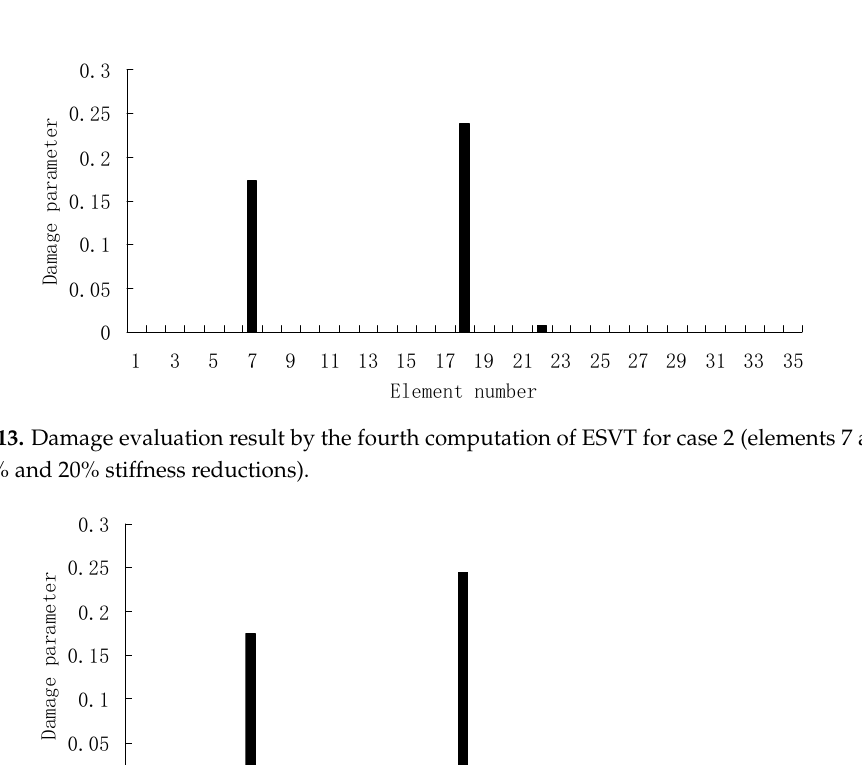
Figure 12. Damage evaluation result by the third computation of ESVT for case 2 (elements 7 and 18 had 15% and 20% stiffness reductions).